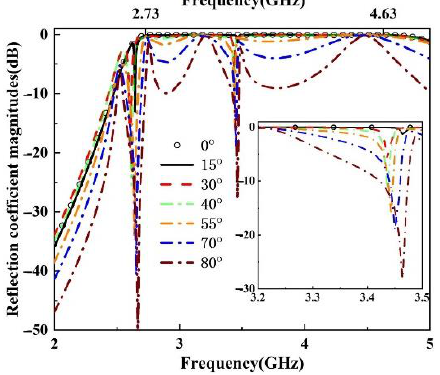
Figure 4. Cross-polarization reflection coefficient amplitudes for various incidence angles.